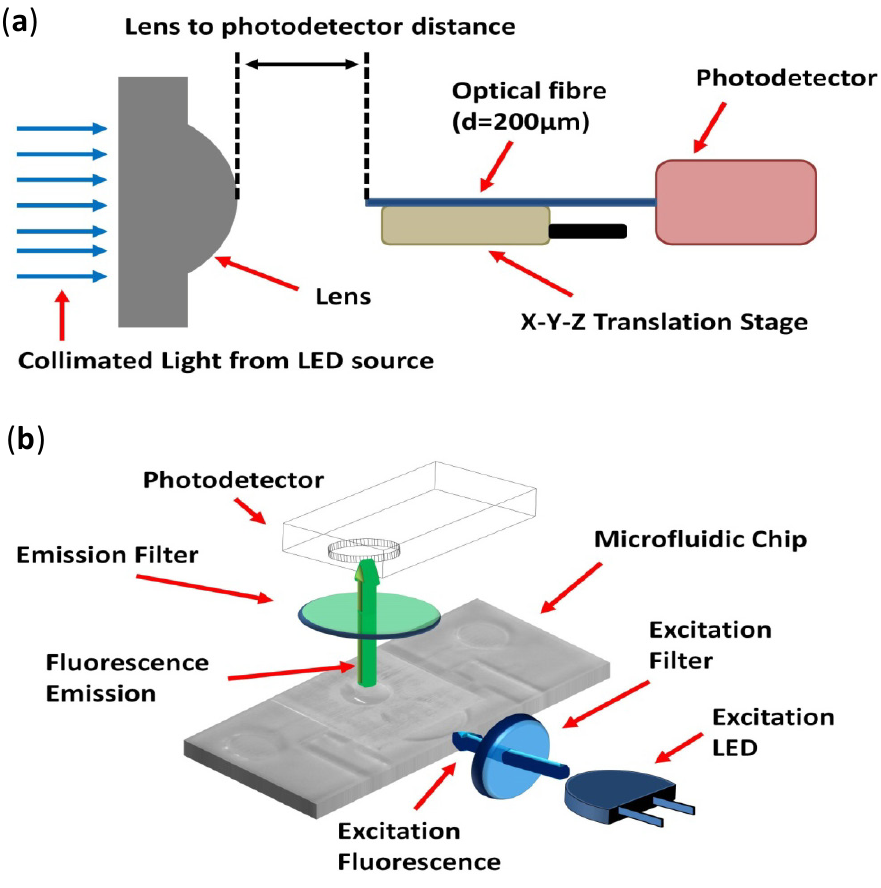
Figure 4. Schematic of the experimental setup to determine ( a ) the lens focal length and ( b ) the FITC fluorescence intensity